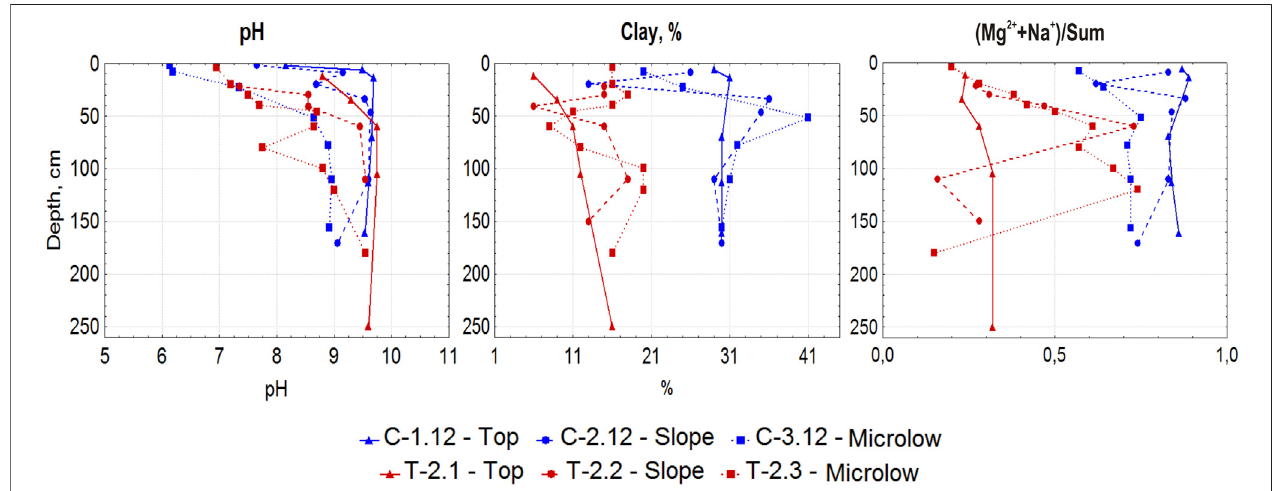
FIGURE 8 | Distribution of pH values, clay content, and the portion of (Na + + Mg 2+ ) in the exchange complex of soils studied at the Churapcha (blue lines) and Tabaga (red lines) sites.